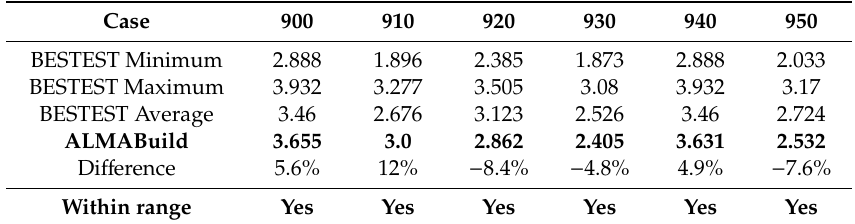
Table 10. Annual Cooling Peak (kW) obtained for non-free-float heavyweight BESTEST cases compared with the minimum and maximum threshold values indicated by BESTEST.